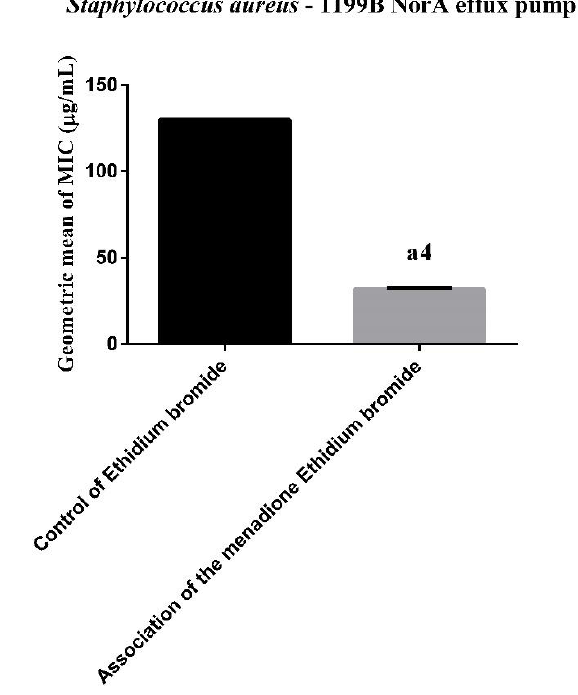
Figure 1. Synergistic effect of menadione on the ethidium bromide against the strain of S. aureus 1199B. Geometric mean ± standard error of the mean, with t -Test. a4: p < 0.0001 vs. control of ethidium bromide.